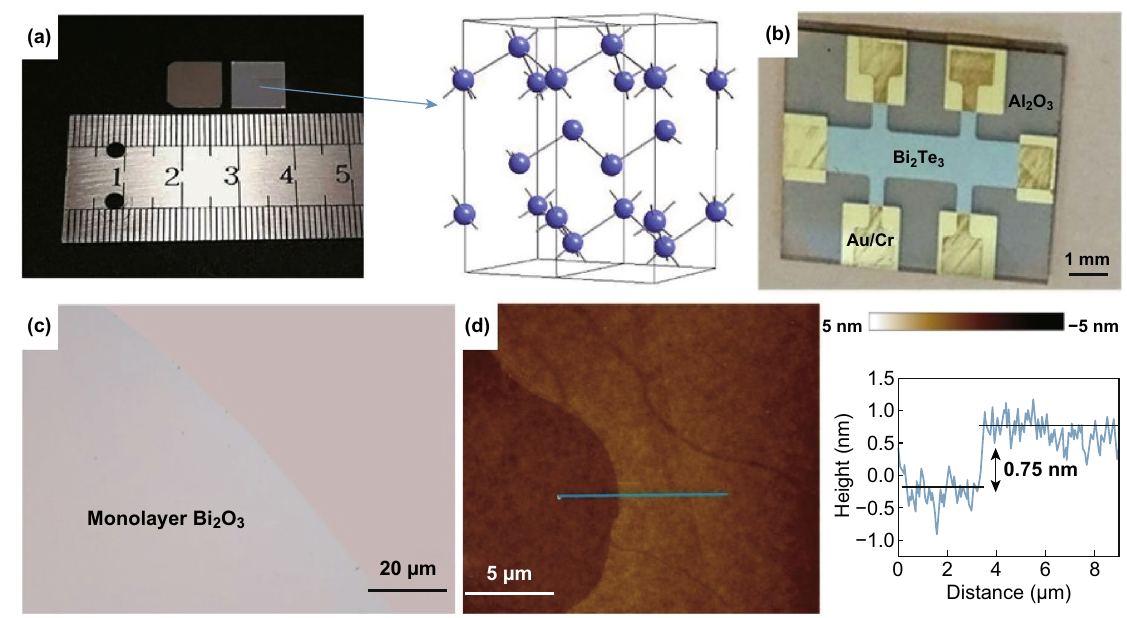
Fig. 8 Large-area synthesis of bismuth compounds. a PLD growth of 2D bismuth on SiO 2 (left) and Al 2 O 3 (right) and the crystal structure elu- cidating bulk bismuth. Adapted with permission from Ref. [108]. Copyright 2019, Wiley. b Optical image of a hall bar device from MBE grown Bi 2 Te 3 on Al 2 O 3 substrate featuring millimetre long topological insulator properties. Adapted with permission from Ref. [109]. Copyright 2017, Elsevier B.V. c LM printed Bi 2 O 3 from the surface of molten bismuth in an oxygen controlled environment and d AFM showing a thickness pro- file of a monolayer. Adapted with permission from Ref. [15]. Copyright 2018, Royal Society of Chemistry Publishing